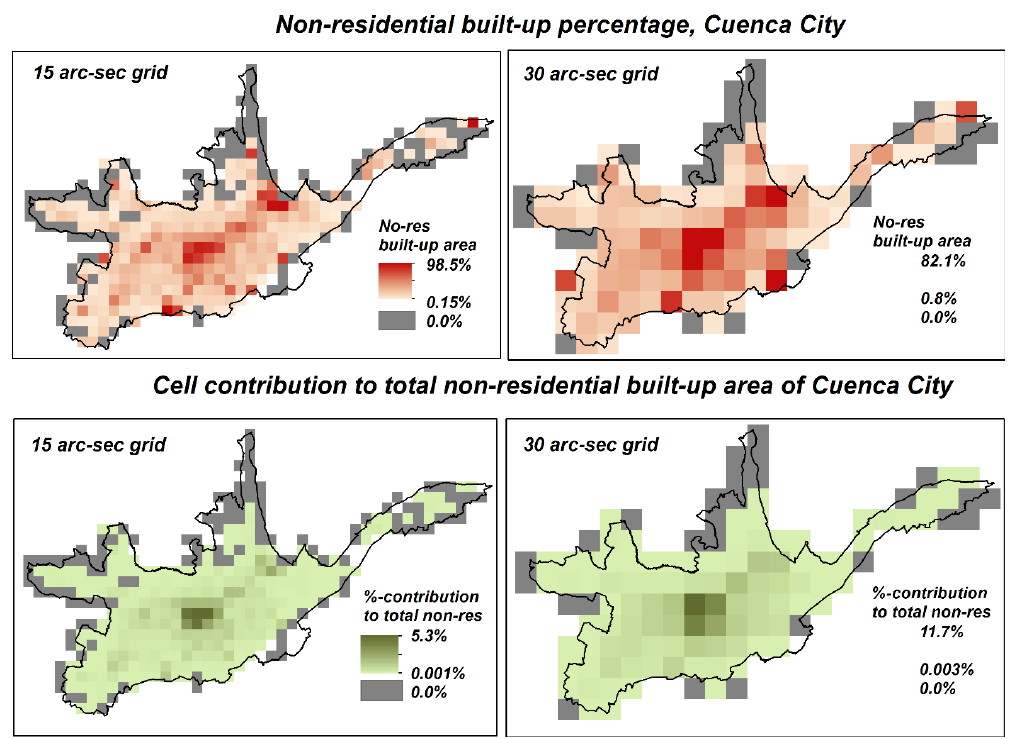
Figure 5. Cadastral data for Cuenca City aggregated to grids at 15 arc-sec ( left ) and 30 arc-sec ( right ) resolution. Non-residential built-up percentage ( top ). Percent-contribution of each cell to the total non-residential built-up area (bottom ).